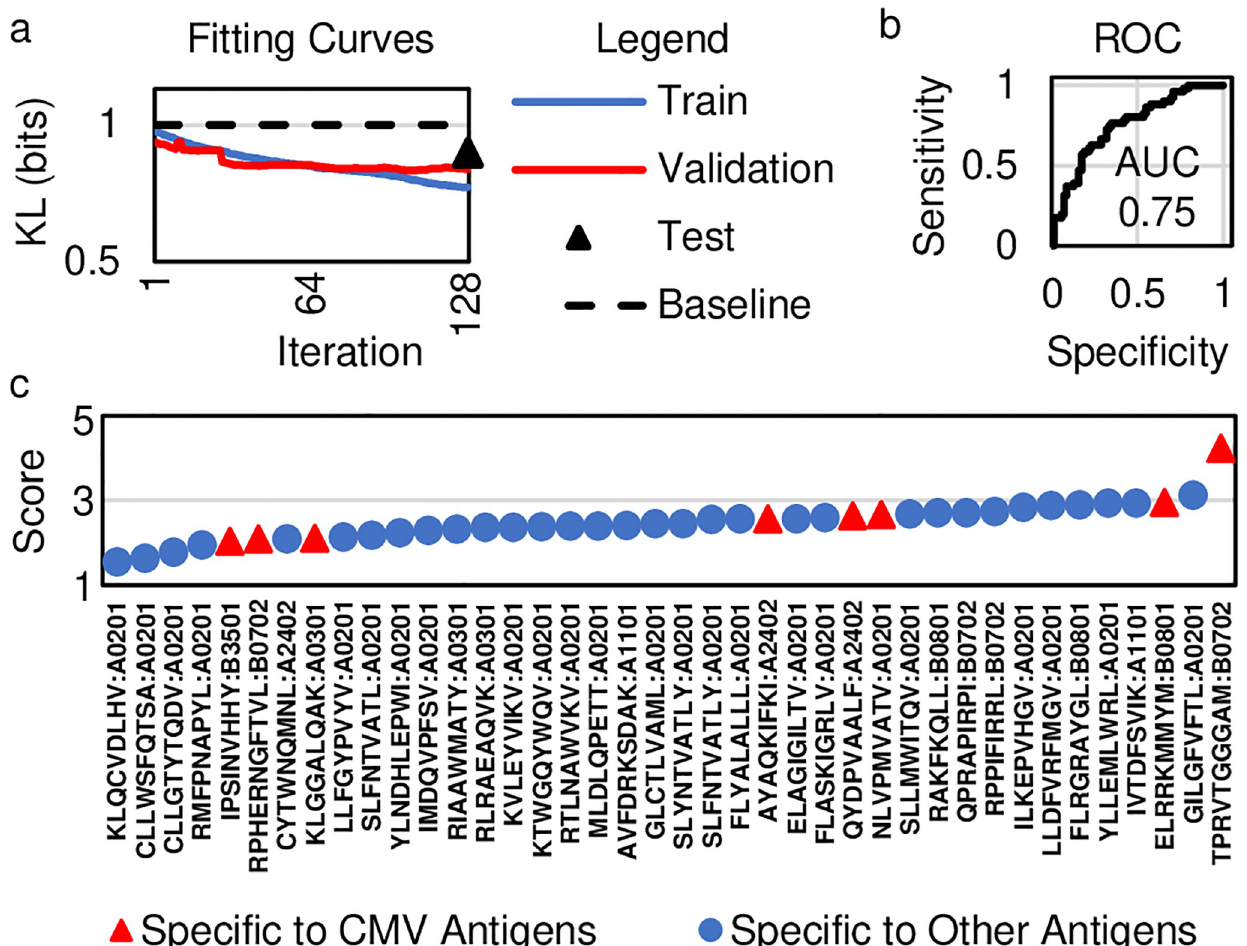
Fig 3. Results on the repertoire Classification problem. (a) The fit plotted for each weight update across the training (solid blue) and validation cohorts (solid red) steadily improves with each gradient optimization step. The fit to the test cohort after unblinding the samples (triangle) is better than the baseline performance achievable by random chance (dashed black). (b) A ROC curve reveals the sensitivity and specificity for various diagnostic thresholds of the model. (c) CDR3 sequences from receptors specific to various pMHCs are scored using the kernel of the model fitted in panel a. The receptors specific to a CMV peptide have the highest score, suggesting that the model has learned to identify receptors specific to this CMV